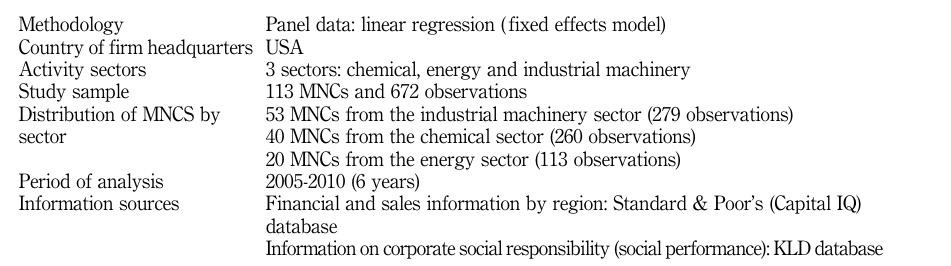
Table I. Summary of